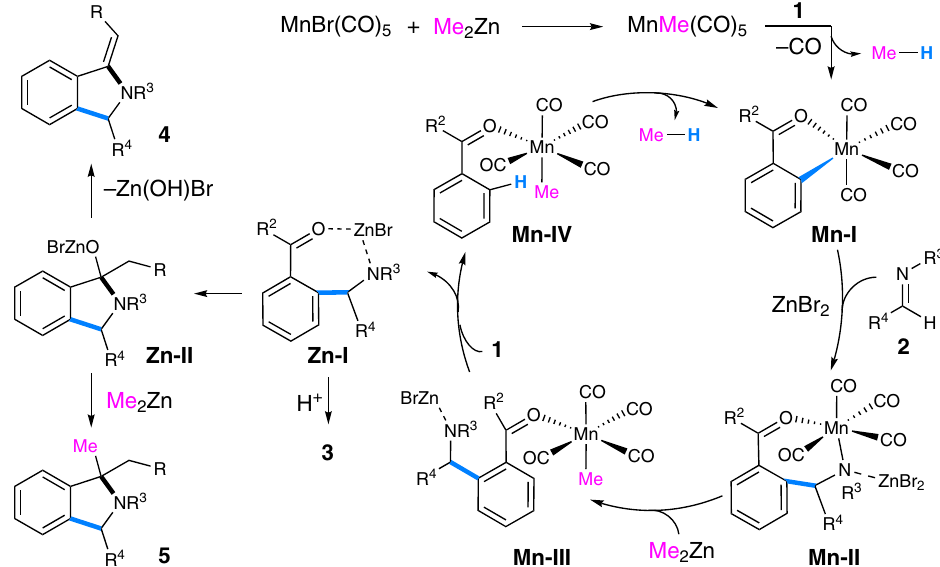
Fig. 10 A proposed reaction mechanism. Key steps include formation of Mn-I followed by addition to imine yielding Mn-II , transmetalation of Mn-II with Me 2 Zn giving Mn-III , then producing Mn-IV and Zn-I by a ligand exchange with 1 , and C – H activation of Mn-IV regenerating Mn-I . Intramolecular cyclization of Zn-I yields Zn-II followed by either an elimination giving 4 or an intermolecular nucleophilic substitution with Me 2 Zn forming